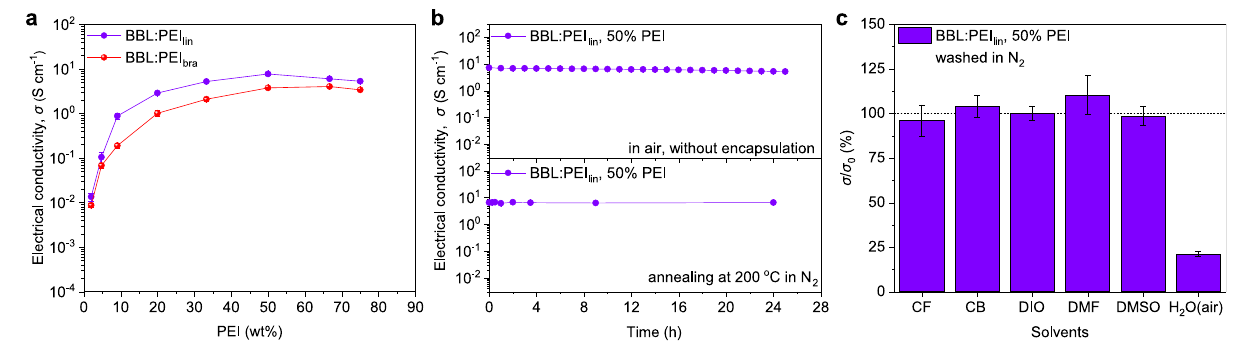
Fig. 3 Electrical properties and stability. a Conductivity of BBL:PEI lin and BBL:PEI bra for different PEI content. b Evolution of conductivity of BBL:PEI lin in air for 24 h and thermal stability when subjected to annealing at 200 °C in nitrogen atmosphere over 24 h. c Stability of BBL:PEI lin exposed to common organic solvents (chloroform (CF), chlorobenzene (CB), 1,8-diiodooctane (DIO), dimethylformamide (DMF), and dimethylsulfoxide (DMSO)), showing changes in conductivity. Error bars indicate the SD of ten experimental